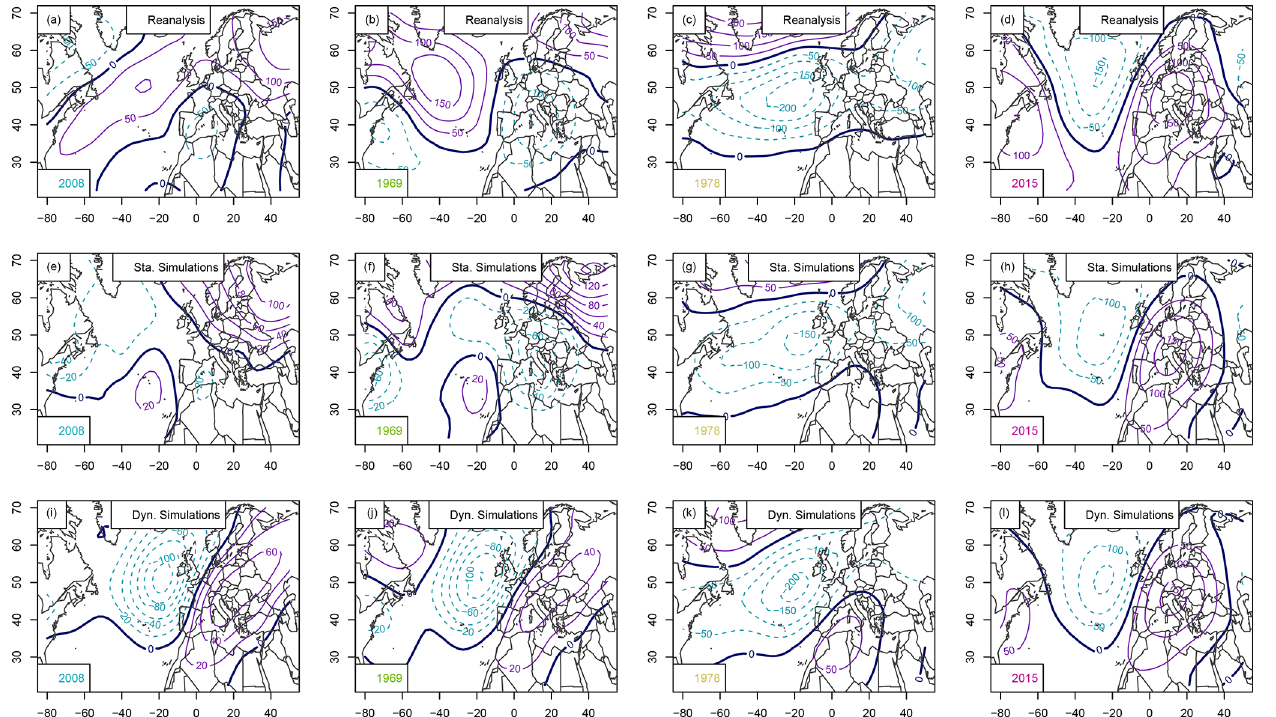
Figure 5. Geopotential height anomaly at 500hPa ( Z 500) composites for a year with 31 cold days (2008), the coldest December (1969), the median (1978), and the warmest December (2015): (a–c) mean Z 500 from NCEP reanalyses, (d–f) static SWG simulations, (g–i) dynamic SWG simulations. Isolines are shown with 100m increments. Positive Z 500 anomalies are shown with continuous purple isolines, negative anomalies are shown with dashed cyan lines, and the 500hPa isoline is shown with a continuous thick black